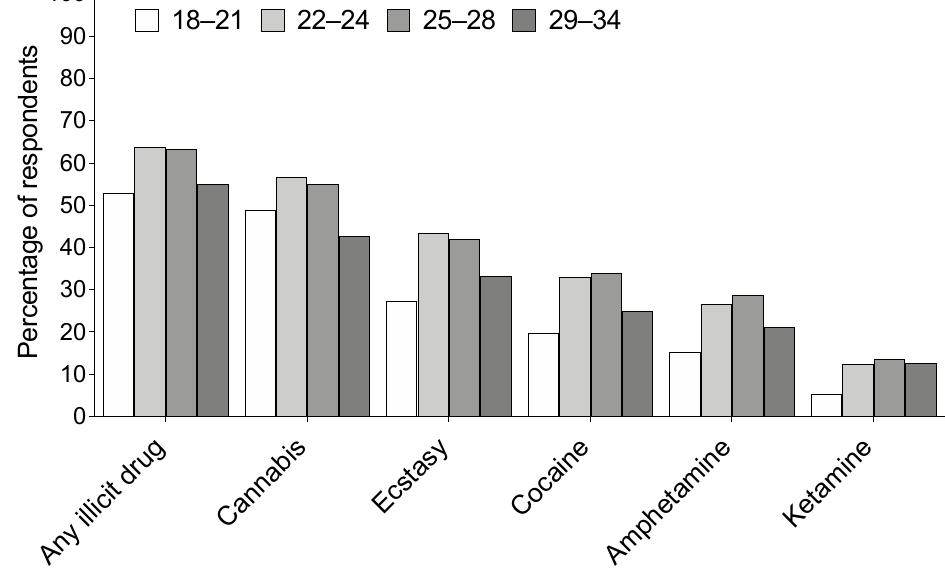
Figure 4. Drug use during the last 12 months depending on age group. Drug use prevalence during the last 12 months was significantly different between age groups for the drugs displayed (chi-square). In contrast, use of LSD (lysergic acid diethylamide) and hallucinogenic mushrooms did not differ between age groups. Drug use prevalence is presented as percentage of all respondents ( n =